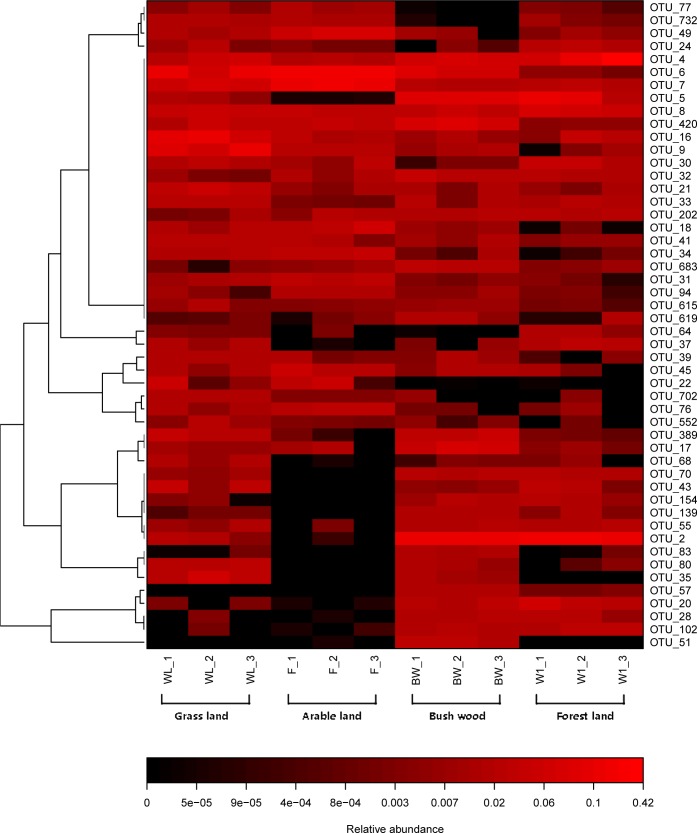
Heat map of top 50 OTUs in all samples.The color intensity (log scale) in each panel shows the percentage of a genus in a sample, referring to color key at the bottom.